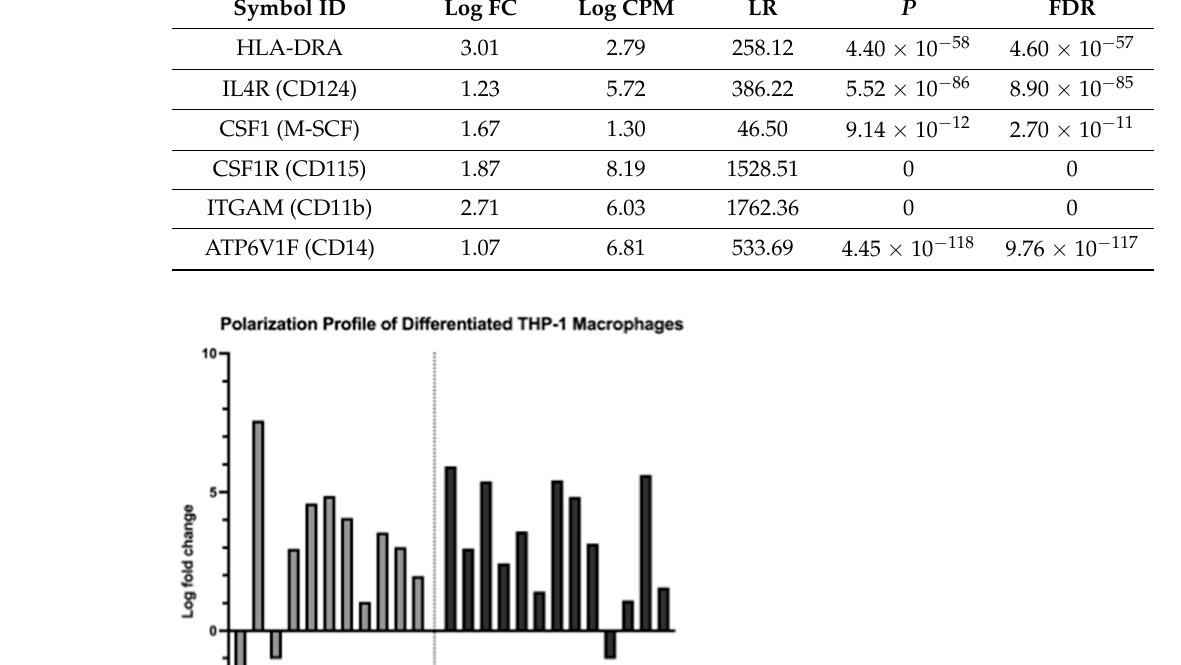
Table 1. Differential gene expression of genes involved in macrophage differentiation from the only significant KEGG pathway enrichment analysis (KEGG pathway hsa04640 “Hematopoetic Cell Lineage”). Genes included are major histocompatibility complex class II DR alpha (HLA-DRA), interleukin 4 receptor (IL4R), colony stimulating factor 1 (CSF1), colony stimulating factor 1 receptor (CSF1R), integrin alpha m (ITGAM), and ATPase H+ transporting v1 subunit F (ATP6V1F). Log FC = log fold change, Log CPM = log counts per million, LR = likelihood ratio, FDR = false discovery rate.